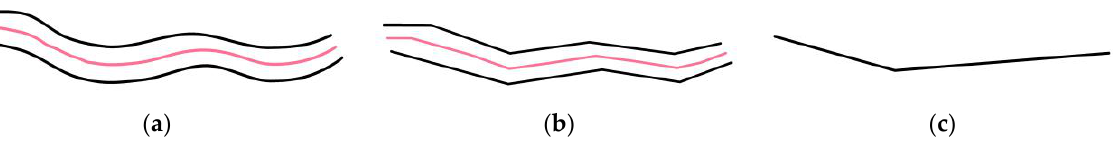
Figure 5. Shape feature extraction of constructed skeleton lines: ( a ) original data; ( b ) the first generalization; ( c ) the second generalization.